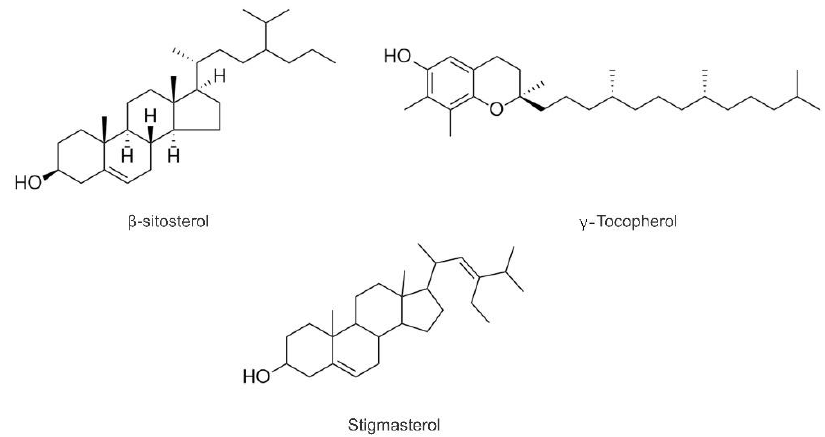
Figure 1. Structures of detected compounds in three QSOs.